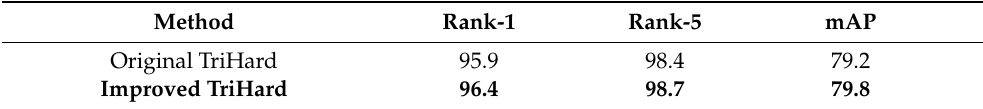
Table 4. Comparison of rank and mAP for original TriHard loss and improved TriHard loss on VeRi-776 [3], where other model’s components and experiment settings remain unchanged.